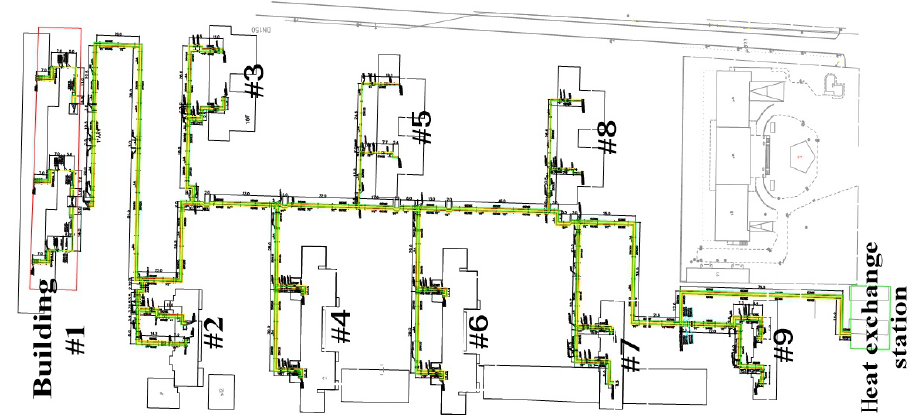
Fig. 8 Community network laying